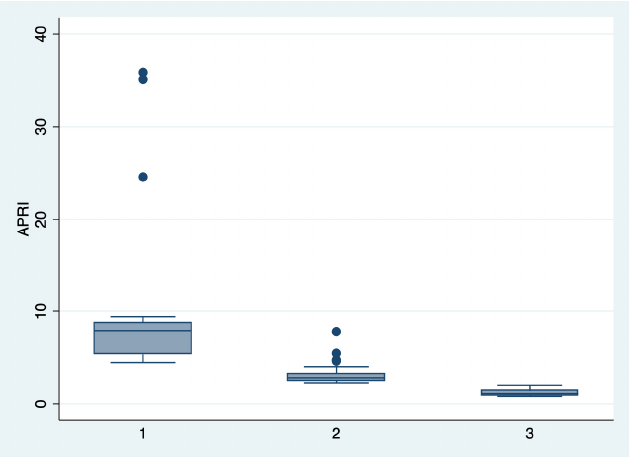
Figure 3. Boxplot representing the comparison of the APRI score in the subgroups 1, 2, and 3. Legend: